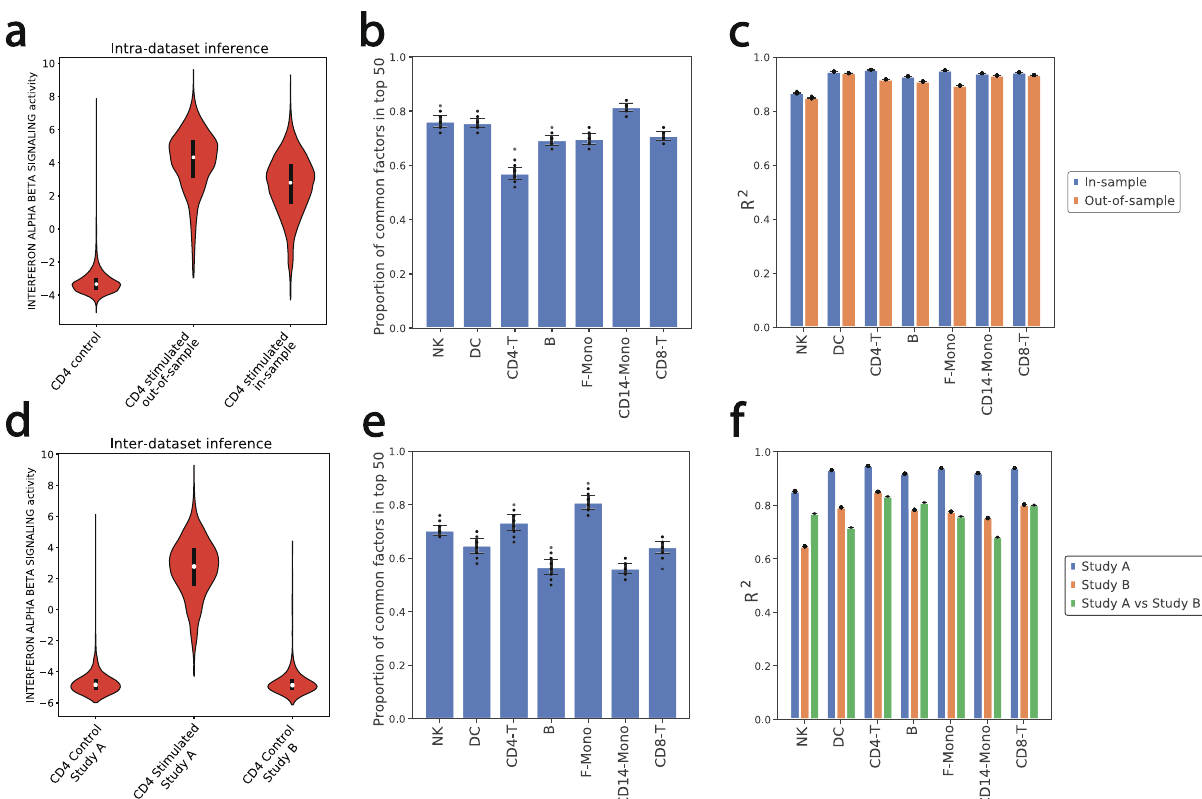
Fig. 4 Generalization of VEGA architecture to out-of-sample data. a Violin plot ( n = 10,000 randomly sampled cells per condition) representing the distribution of the interferon- α / β pathway activity in control CD4-T cells, stimulated CD4 T cells unseen at the time of training (out-of-sample), and stimulated CD4-T cells when included in the training procedure (in-sample). Boxes inside the violins represent the median of the distribution bounded by the fi rst and third quartile. Violin limits correspond to data extrema. b Proportion of overlap in the top 50 differentially activated GMVs in the in-sample and out-of-sample settings with stimulated vs control differential procedures for the seven main cell types in the study. Data were presented as mean values ± standard deviation over 100 random sampling. c R 2 between the mean expression of real and reconstructed cells in the in-sample and out-of- sample settings for the seven main cell types of the study. Data were presented as mean values ± standard deviation over 100 random samplings. d Violin plot ( n = 2000 randomly sampled cells per condition) of distribution of the interferon- α / β pathway activity in control CD4-T cells of study A (Kang et al. 17 ), stimulated CD4-T cells of study A and control CD4-T cells of study B (Zheng et al. 32 ). Boxes inside the violins represent the median of the distribution bounded by the fi rst and third quartile. Violin limits correspond to data extrema. e Proportion of overlap in the top 50 differentially activated GMVs of each study with one-vs-rest differential procedures for the control cells of the seven main PBMC cell types. Data were presented as mean values ± standard deviation over 100 random samplings. f R 2 between the mean expression of real and reconstructed cells of study A (Study A), mean expression of real and reconstructed cells of study B (Study B), and mean expression of real cells of study A and real cells of study B (Study A vs Study B). Data were presented as mean values± standard deviation over 100 random